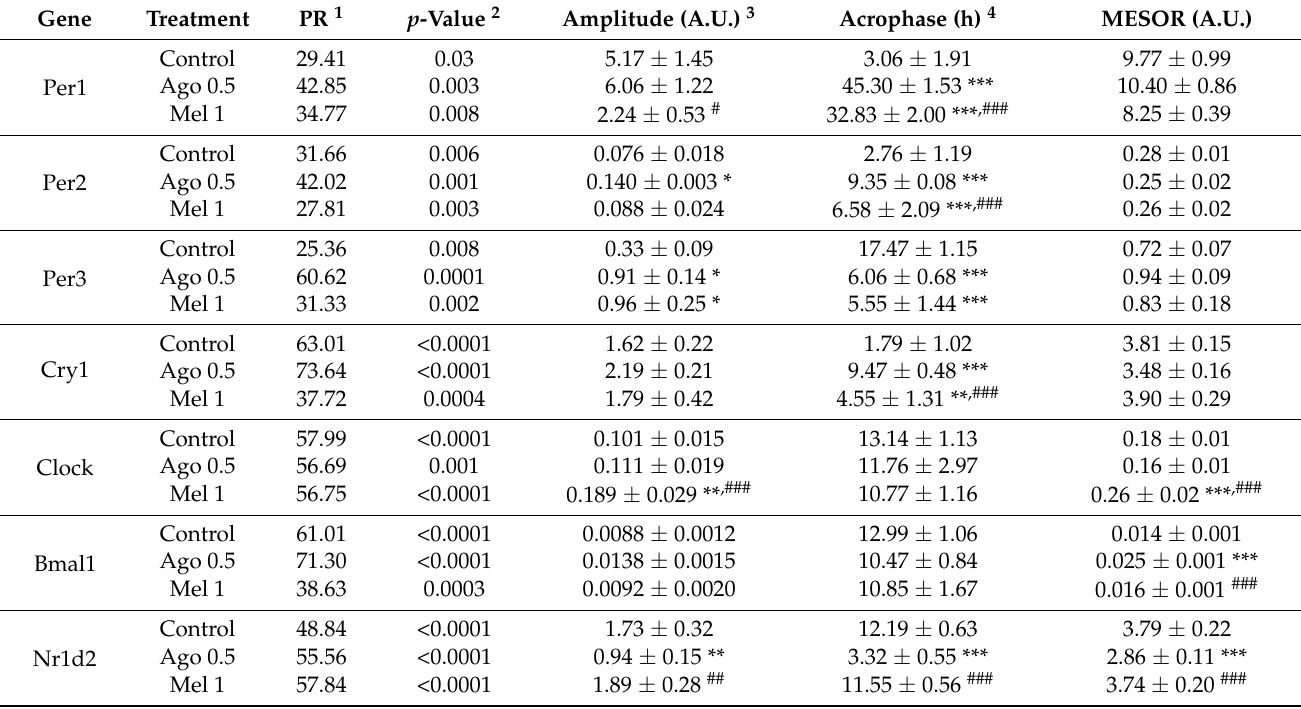
Table 1. Results of the cosinor analysis of the clock genes’ expression after agomelatine or melatonin treatment in the HCT-116 cell line.